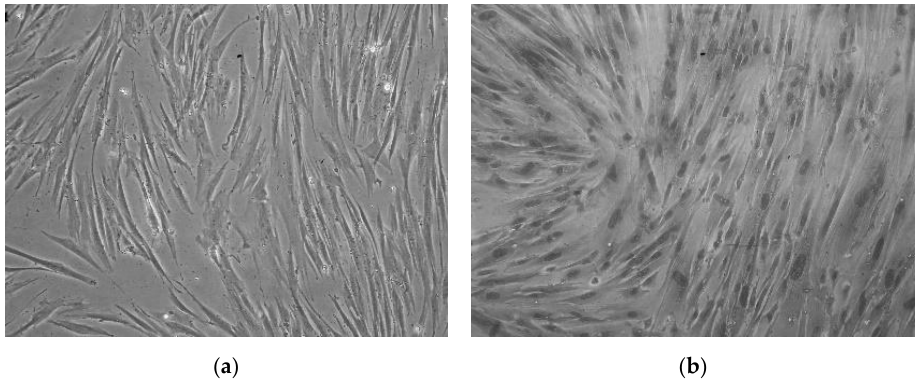
Figure 1. ( a ) Monolayer culture human chorionic mesenchymal stem cells (CMSCs) after 10 days. ( b ) CMSCs characterized by an elongated shape; morphologically the cells are spindle-shaped and adherent (20× magnification of objective).